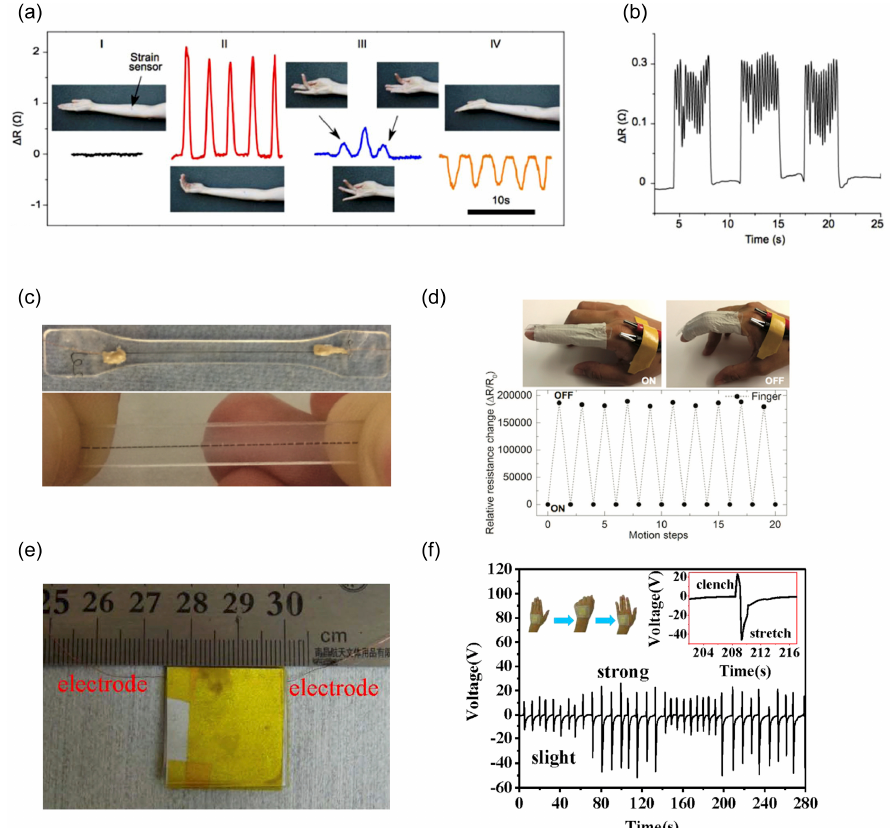
Figure 8. Sensors for non-invasive muscle and joint monitoring. ( a ) Application of nanofiber sensor